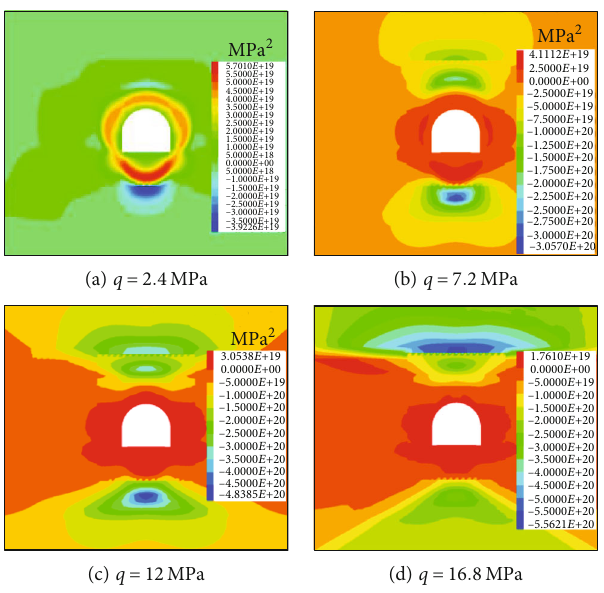
Figure 7: The J 3 distribution under various deviatoric stresses.